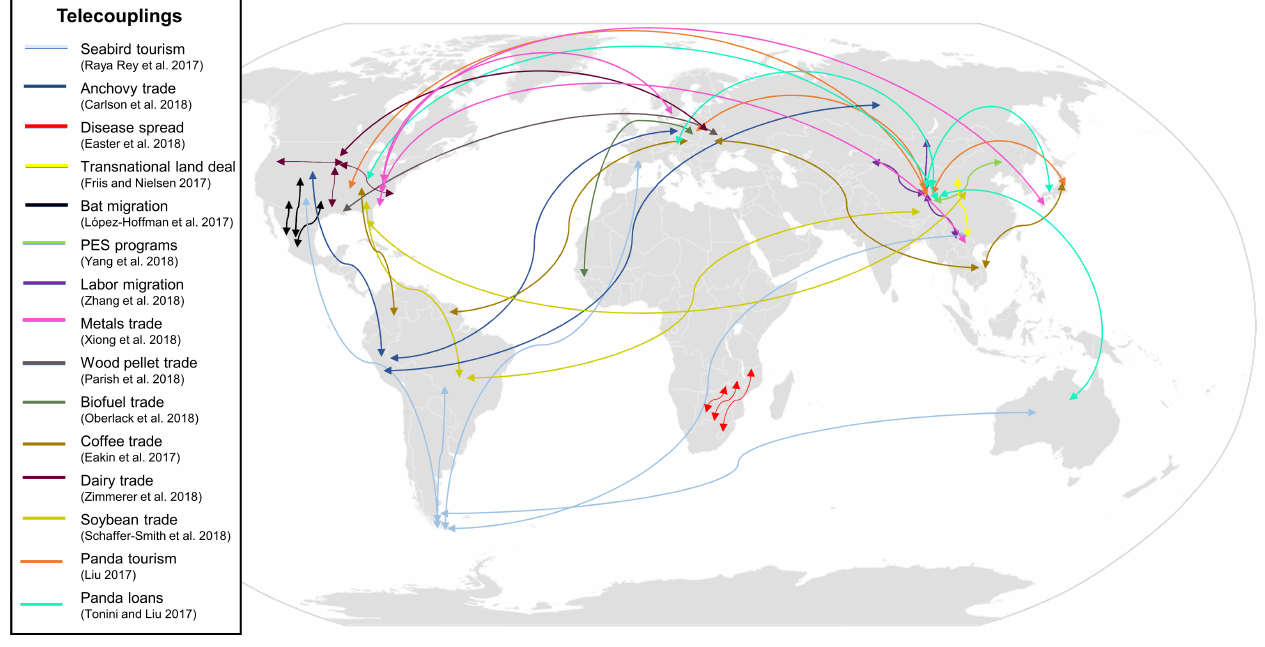
Fig. 2 . Map showing spatial extent of representative flows from select telecouplings explored in the special